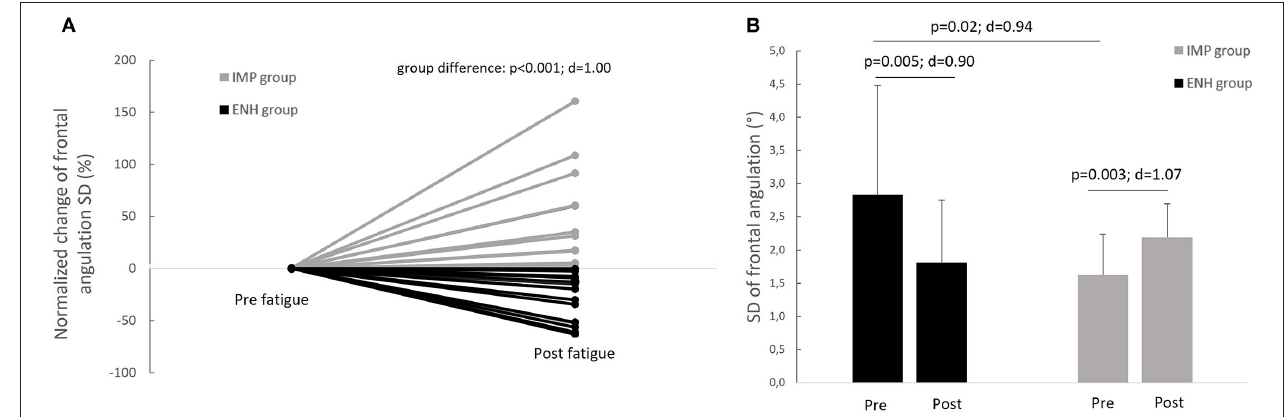
FIGURE 3 | (A) Inter-individual variability of the evolution of frontal angulation standard deviation index in response to fatigue and (B) comparison of the evolution of frontal angulation standard deviation index with fatigue between the enhanced-stability (ENH) and the impaired-stability (IMP) groups.